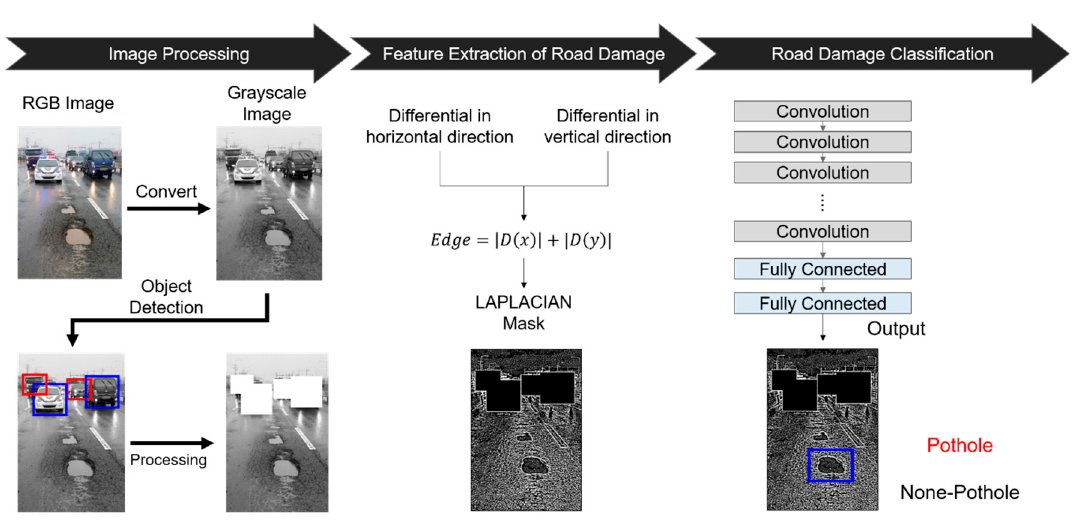
Figure 6. Process of the pothole classification model using edge detection in road image.